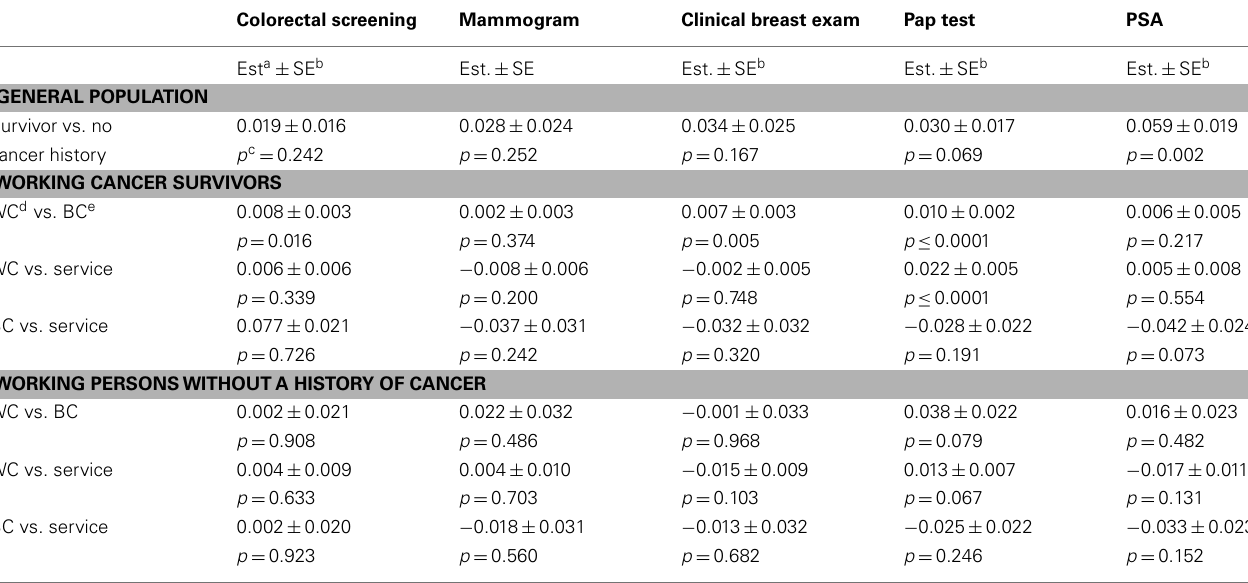
Table 5 | Comparison of trend (slopes) in adherence to cancer screening over the decade (National health interview survey